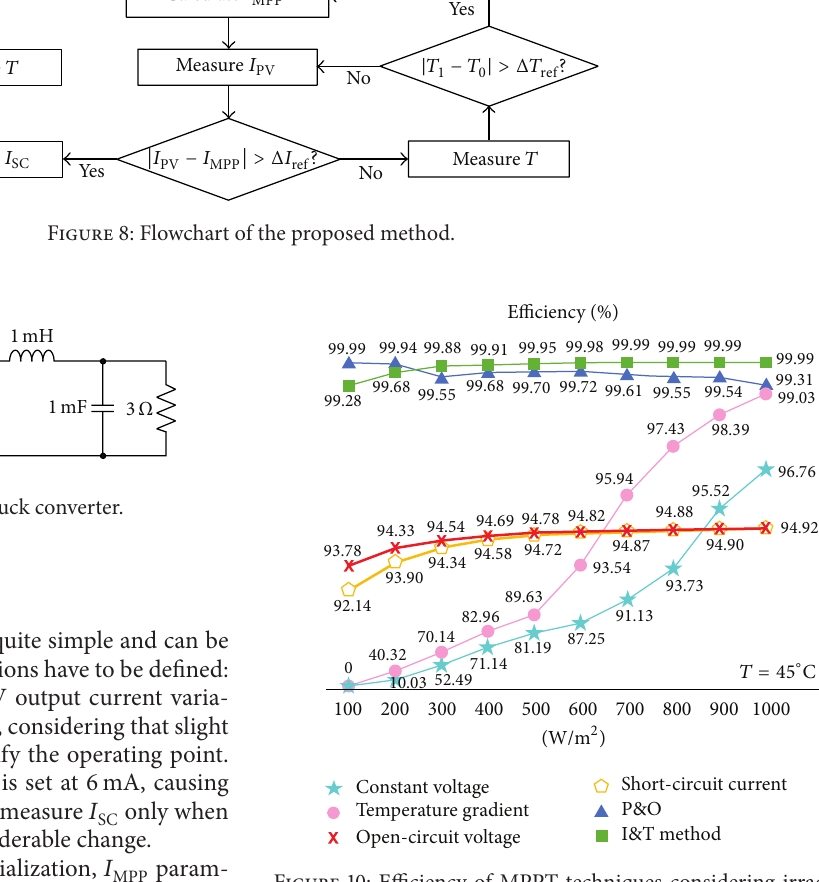
Figure 10: Efficiency of MPPT techniques considering irradiance